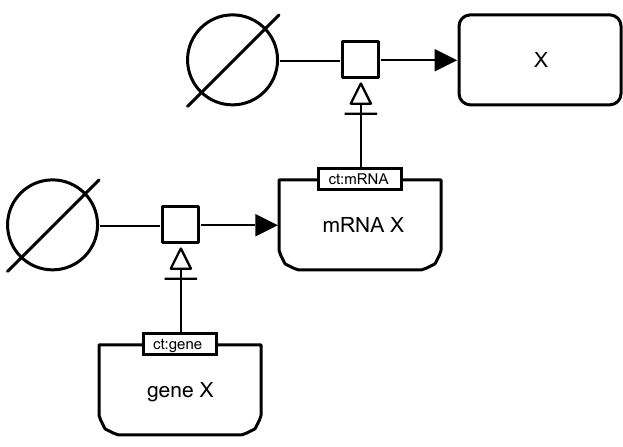
Figure 2.47: The creation of a messenger RNA X triggered by the gene